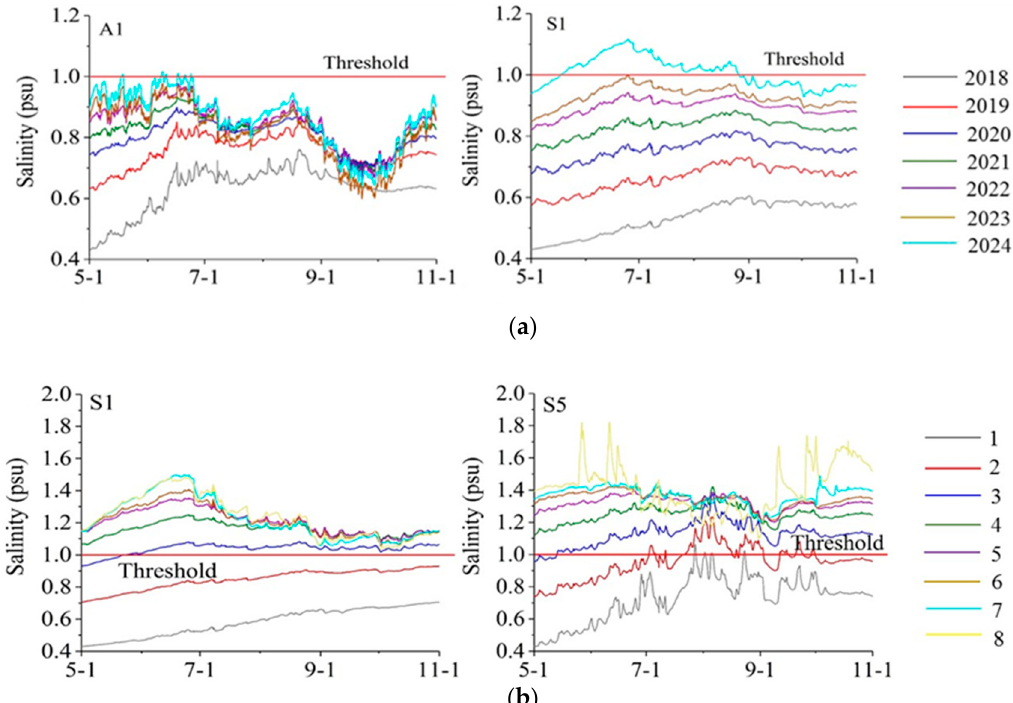
Figure 10. Time series prediction of salinity in the lake exceeding threshold under scenario ( a ) and scenario ( b ) at nine stations. A1, S1, and S5 indicate the observed stations.